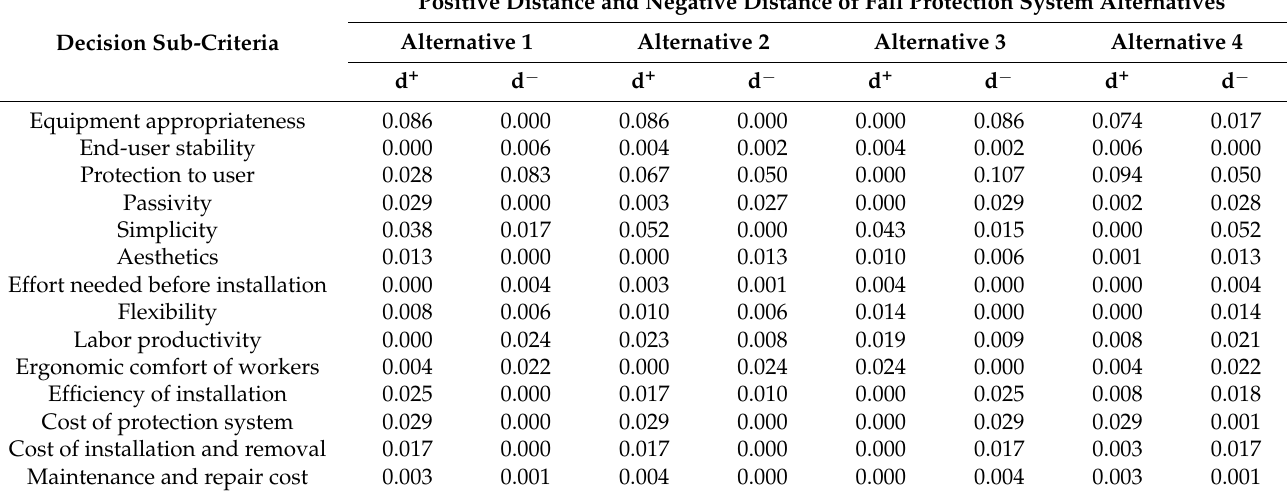
Table 9. Positive distance and negative distance of fall protection